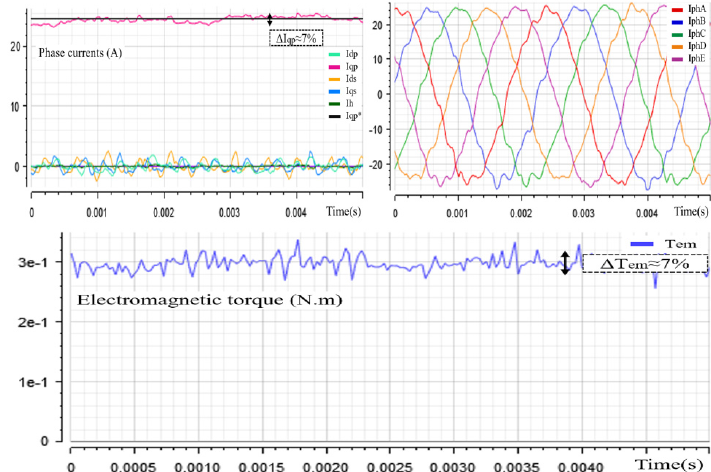
Figure 9. Stator currents and electromagnetic torque in Healthy condition.